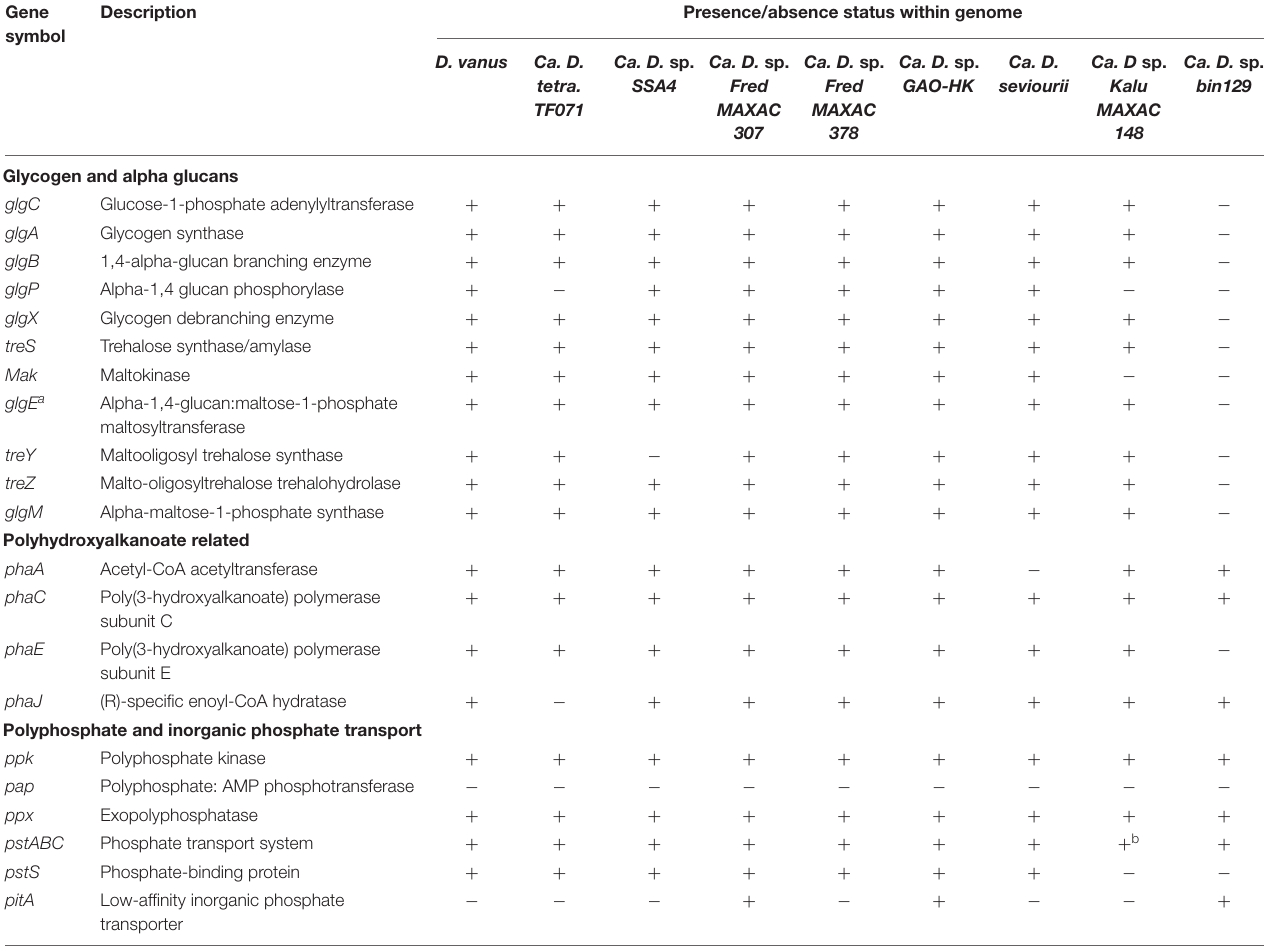
TABLE 4 | Selected genes related to polymeric metabolism in genomes from members of the genus Defluviicoccus. Gene Description symbol